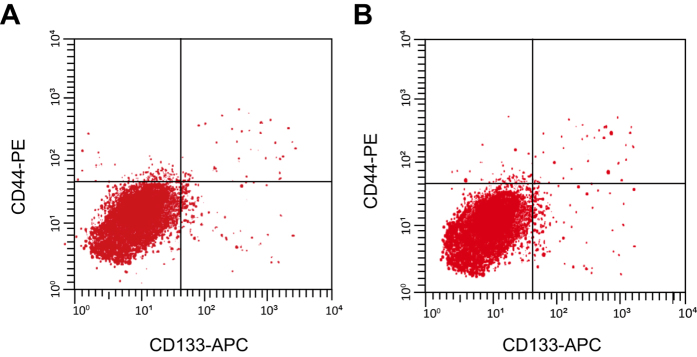
CD133+CD44+ cells in SCC-9 and Tca8113 cell lines sorted by flow cytometry.Note: (A) the distribution of cells marked with CD133-APC and CD44-PE antibodies, with the upper right quadrant being the CD133+CD44+ cells in SCC-9 cell line, whose percentage was 6.50%; (B) the distribution of cells marked with CD133-APC and CD44-PE antibodies, with the right upper quadrant being the CD133+CD44+ cells in Tca8113 cell line, whose percentage was 7.11%; OSCSCs, oral squamous carcinoma stem cells.